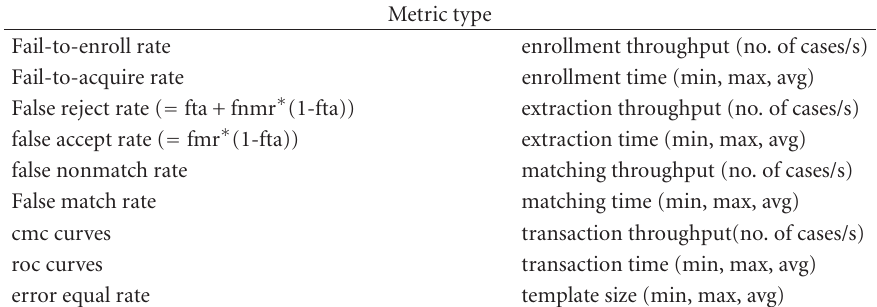
Table 4: Selected performance evaluation